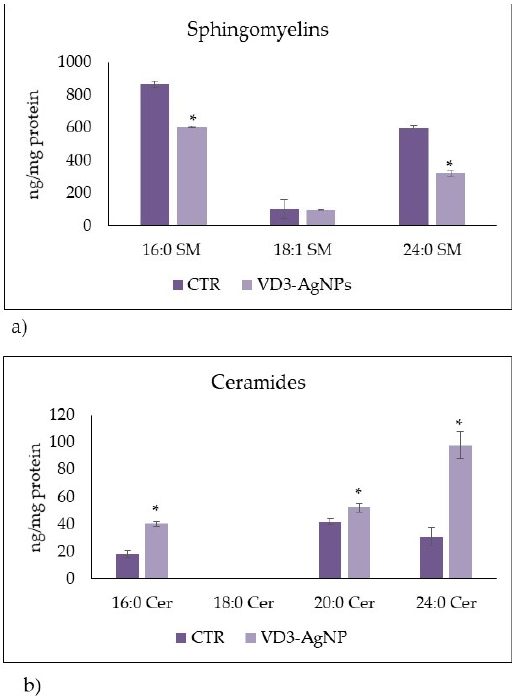
Figure 5. LC MS/MS analysis of SM and Cer species upon VD3-AgNP treatment. ( a , b ) Control (Ctr) and experimental (Ex) cells. The analysis was performed as reported in the Section 4. Data are expressed as ng/mg protein and represent the mean ± SD of two independent experiments performed in duplicate. * p < 0.05 versus control sample.